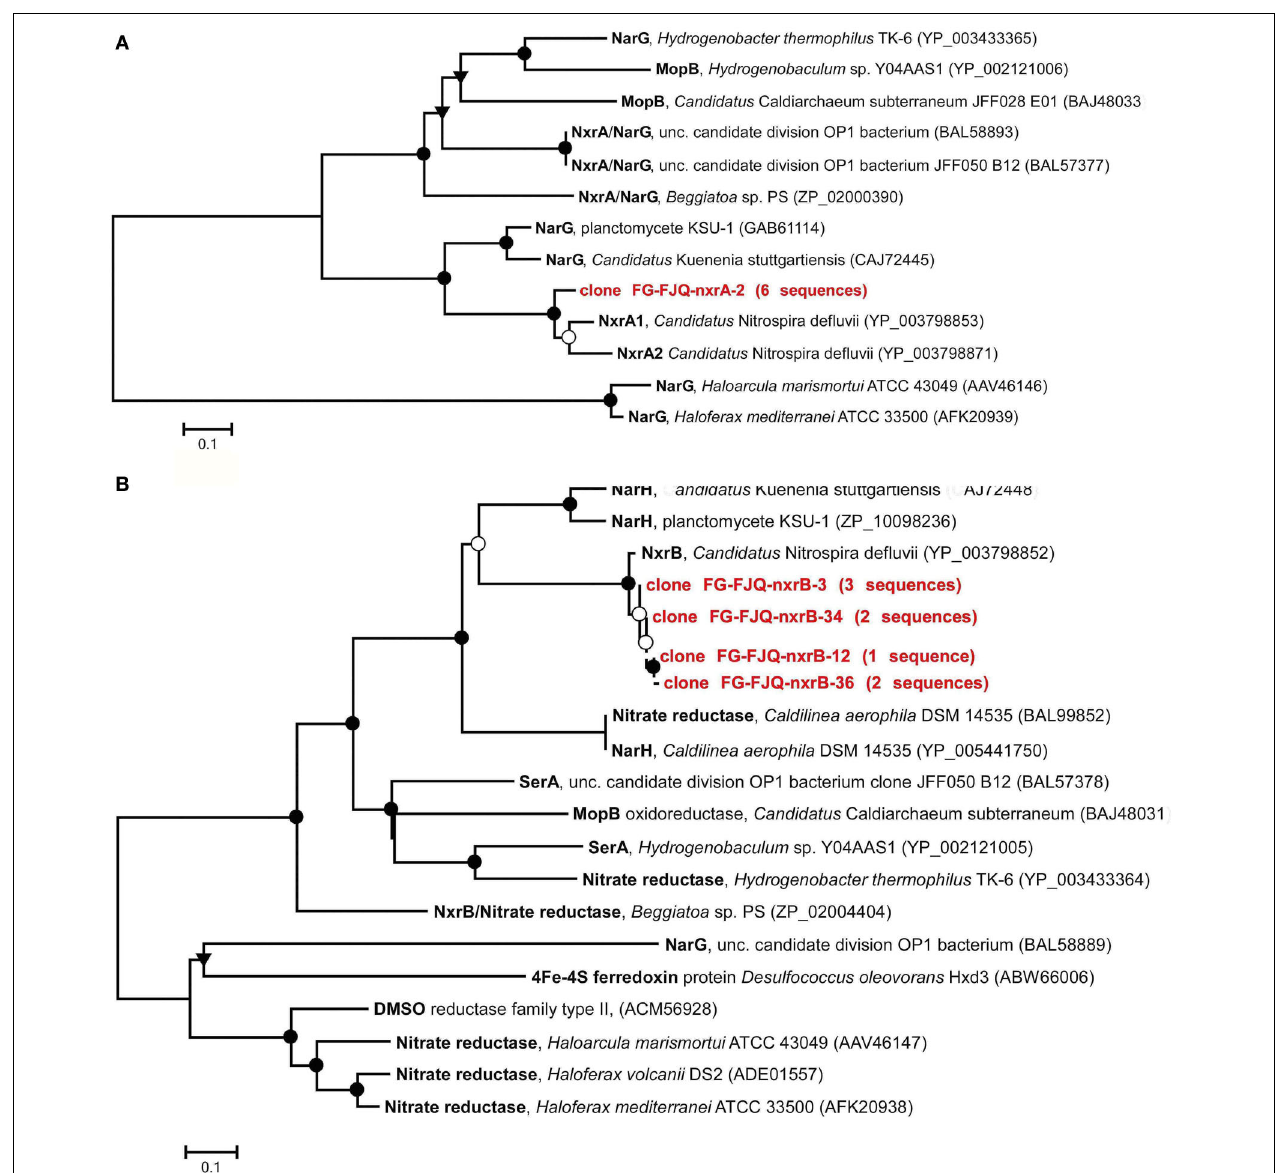
FIGURE 4 | Phylogenetic relationships within the molybdopterin-binding protein superfamily. (A) Dendrogram derived from the deduced protein sequence (226 amino acids) encoded by the nxrA gene and closest related sequences for alpha subunits of the subfamily of enzymes within the MopB protein superfamily. Abbreviations: NxrA, nitrite oxidoreductase alpha subunit; NarG, membrane bound respiratory nitrite reductase; MopB, molybdopterin oxidoreductase. (B) Dendrogram derived from the deduced protein sequences